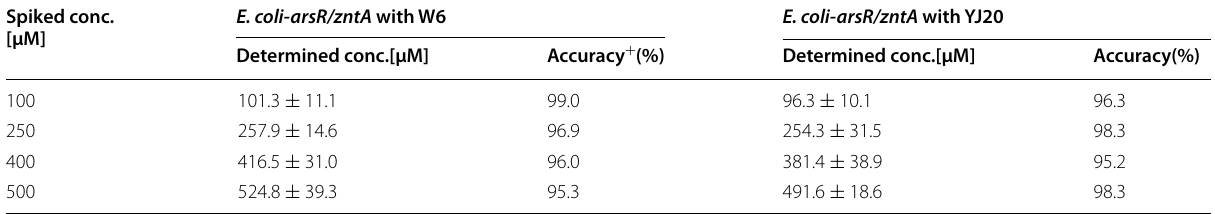
+ Accuracy was calculated by the coverage of Pb quantification over originally spiked concentrations